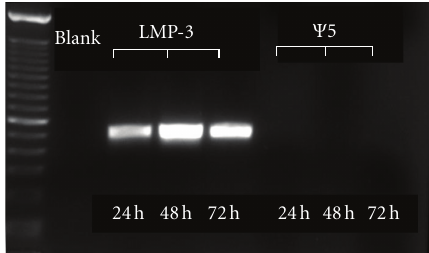
Figure 1: Transduction e ffi ciency. RT-PCR showing transgenic LMP-3 expression (visible bands) up to 72 hours after cell transduction. No transgene expression can be detected in the control cells transduced with Ad Ψ